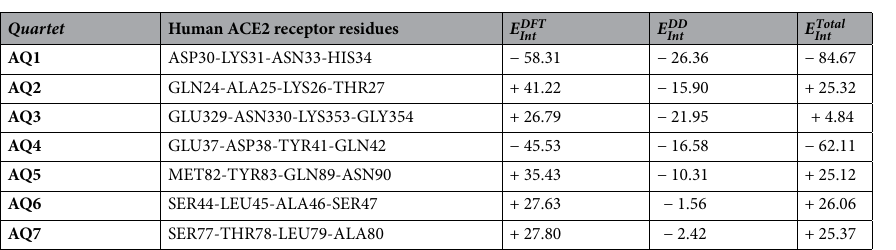
Table 1. hACE2 quartets and their interaction energies [kcal/mol] a with neighboring b SARS-CoV-2 S-RBD residues. a DFT energies computed at 6-311+G(d,p)/B3LYP level; Dispersion (DD) corrections evaluated with semiempirical method 22 . b S-RBD residues within 4.5 Å of hACE2 quartet non-hydrogen atoms included.